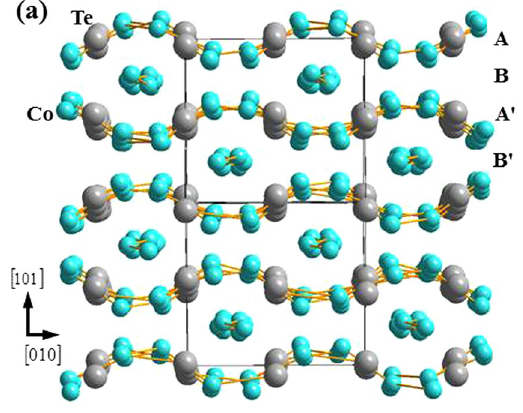
Figure 1. Network of the severely distorted Co/Te layers viewed along the [1, 0, − 1] axis direction, without the presence of interconnecting O ions for clarity. The layers marked A ′ and B ′ can be reached by a translation operation of layers marked A and B, respectively, through ( a /2, b /2, 0).